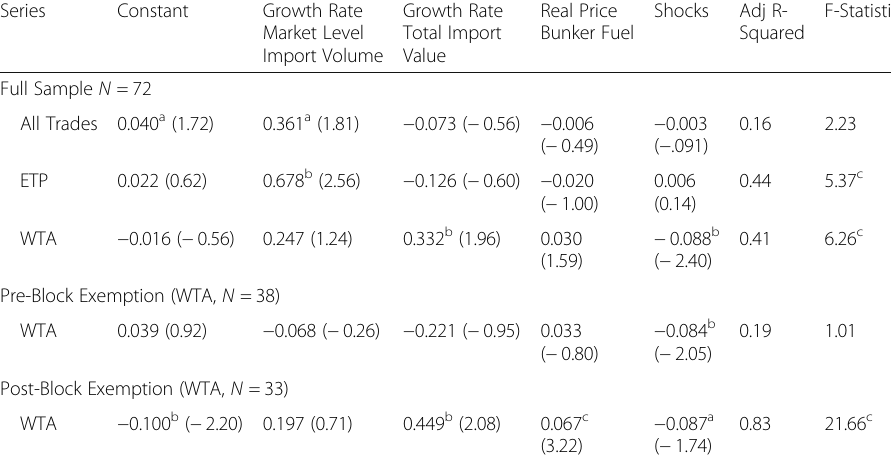
Growth Rate Real Price Shocks Adj R- F-Statistic Bunker Fuel Squared Market Level Total Import Import Volume Value